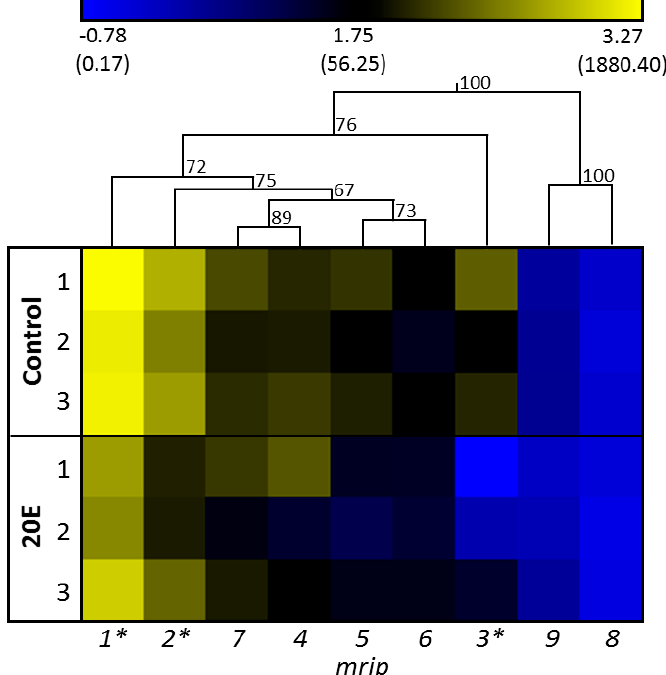
Figure 2. One-way hierarchical clustering analysis heat map and dendrogram of mrjp gene expression in the control group compared to the 20E group. Each group comprised three cage replicates, with nine analyzed honey bees per replicate. Gene expression is presented as a color gradient across all samples, from deep blue (lowest) to light yellow (highest). Asterisks indicate significant differences ( p < 0.05) between control group and 20E group (general linear model (GLM), post-hoc Bonferroni test). Expression values were log transformed for the clustering. Relative gene expression values are shown in brackets.